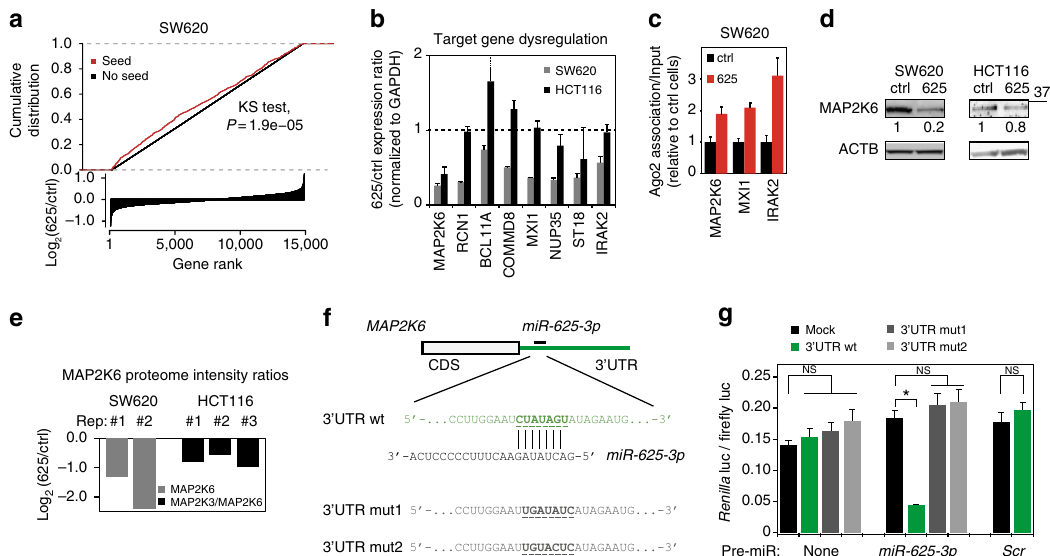
Figure 4 | MAP2K6 is a direct and functional target of miR-625-3p. ( a ) Genes were ranked according to differential expression after miR-625-3p induction in SW620 cells (log 2 (625/ctrl) (bottom panel). The cumulative distribution of genes with a miR-625-3p seed sequence (red) was significantly different from the distribution of genes without a seed sequence (black) ( P ¼ 1.9*10 (cid:2) 5 , Kolmogorov–Smirnov test; top panel). Note that for clarity, the log 2 (625/ctrl)-scale is truncated at (cid:2) 1 and 1. ( b ) The 625/ctrl-expression ratios of eight candidate target genes were determined by qRT–PCR after induction of miR-625-3p (or control) in SW620 cells and HCT116 CRC cells. Shown are mean expression ratio ± s.e.m. ( n ¼ 3). ( c ) qRT–PCR quantification of candidate target genes in RNA from AGO2-associated precipitates and normalized to GAPDH in input. Mean association ± s.e.m. ( n ¼ 3) displayed relative to control cells. ( d ) Representative western blots of MAP2K6 in SW620 and HCT116 cells after DOX-induction for 48h. b -Actin (ACTB) was used as loading control. Quantification of MAP2K6 band intensities (normalized to ACTB) is indicated. ( e ) Quantification of MAP2K6 downregulation after induction of miR-625-3p as determined by mass-spec proteome analysis of two (SW620) or three (HCT116) independent DOX inductions. Displayed as log 2 mean peptide intensity ratio. For SW620 data, 20–45kDa proteins were excised from a denaturing gel and subjected to unlabelled proteome quantification. For HCT116 data, we used isotope-labelled whole cell lysates described below (see Fig. 6a). Note that while one MAP2K6 specific peptide was quantified in the SW620 lysates, only peptides ( n ¼ 2) shared between MAP2K3 and MAP2K6 were detected in HCT116 cells. ( f ) Structure of the 3 0 UTR of MAP2K6 (ENSG00000108984, miR-625-3p binding site at 3 0 UTR position 173–180). The close-up depicts miR-625-3p annealed to the wild-type target sequence (underlined) as well as the two mutated sequences used in g . ( g ) Mean normalized Renilla Luc signal ± s.e.m. ( n ¼ 3) from HEK293Tcells 24h after transfection with psiCHECK-2 reporter containing MAP2K 3 0 UTR, either of the mutated 3 0 UTR sequences shown in f or mock.